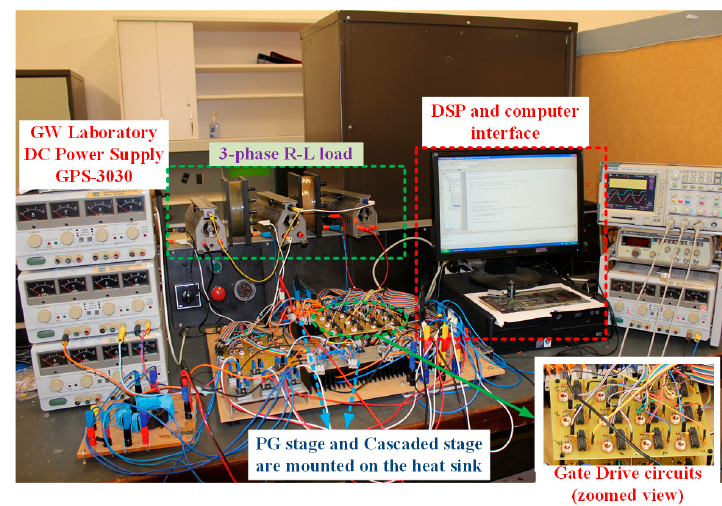
Figure 7. Experimental prototype hardware model. Reprint with permission [4261051118814]; 2018, IEEE.